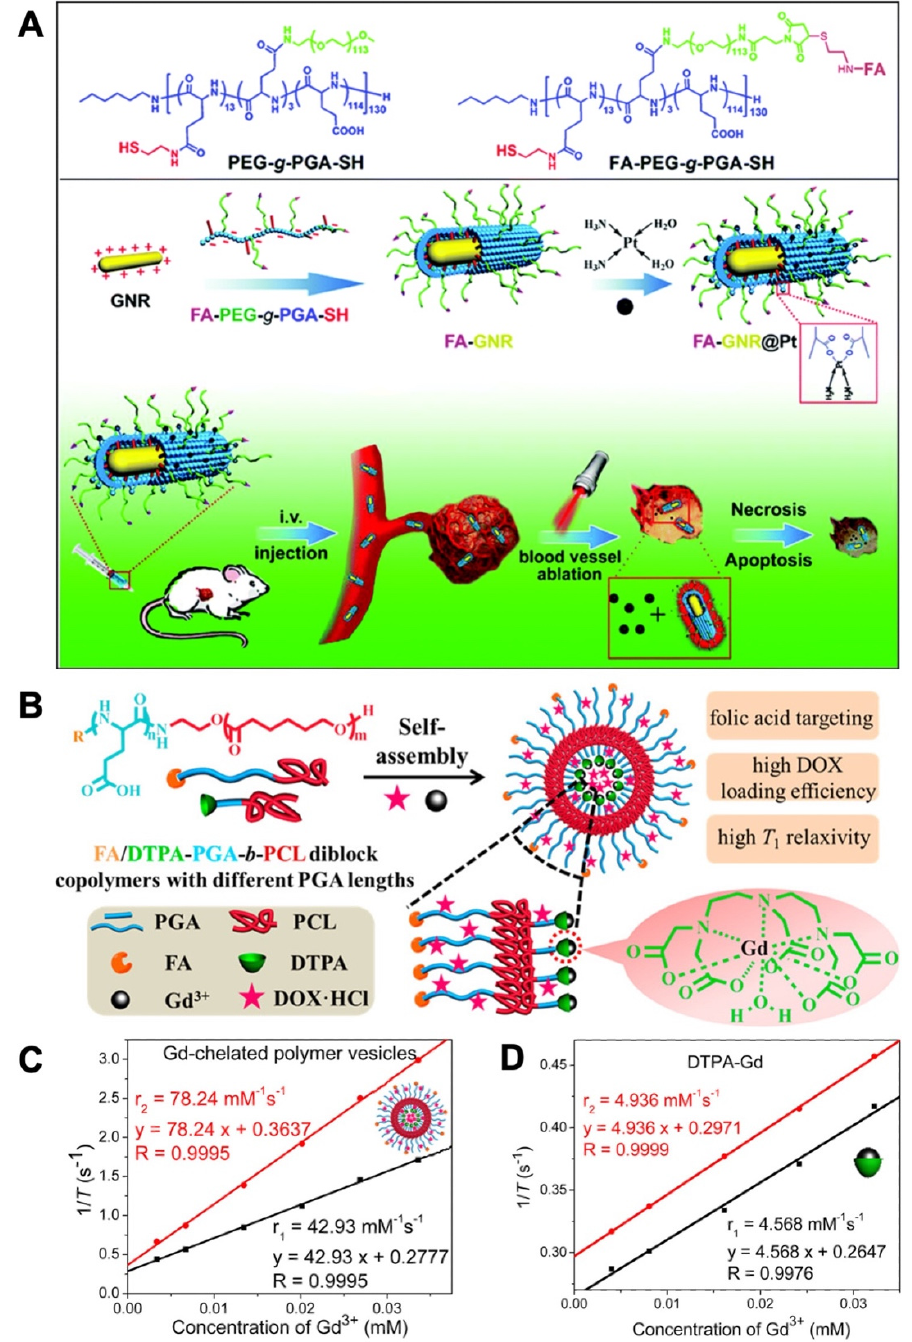
Figure 7. Combined treatment based on chemotherapy, PTT, and MRI. ( A ) Combinational chemo- photothermal therapy of breast cancer by utilizing the FA–targeted GNR@Pt prodrug. Reprinted with permission from Ref. [84]. Copyright 2015, The Royal Society of Chemistry. ( B ) Asymmetrical polymeric vesicles with multi functions for ultrasensitive MRI and targeted tumor therapy. ( C , D ) The T1 relaxivity of Gd(III) –chelated asymmetrical vesicles and traditional DTPA–Gd. Reproduced with permission. Reprinted with permission from Ref. [85]. Copyright 2015, American Chemical Society.